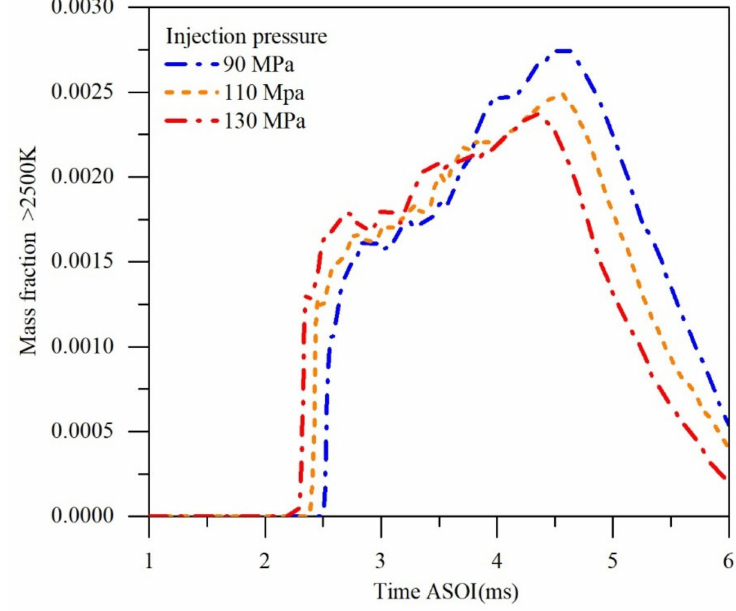
Figure 20. The mass fraction of reaction fuel above 2500